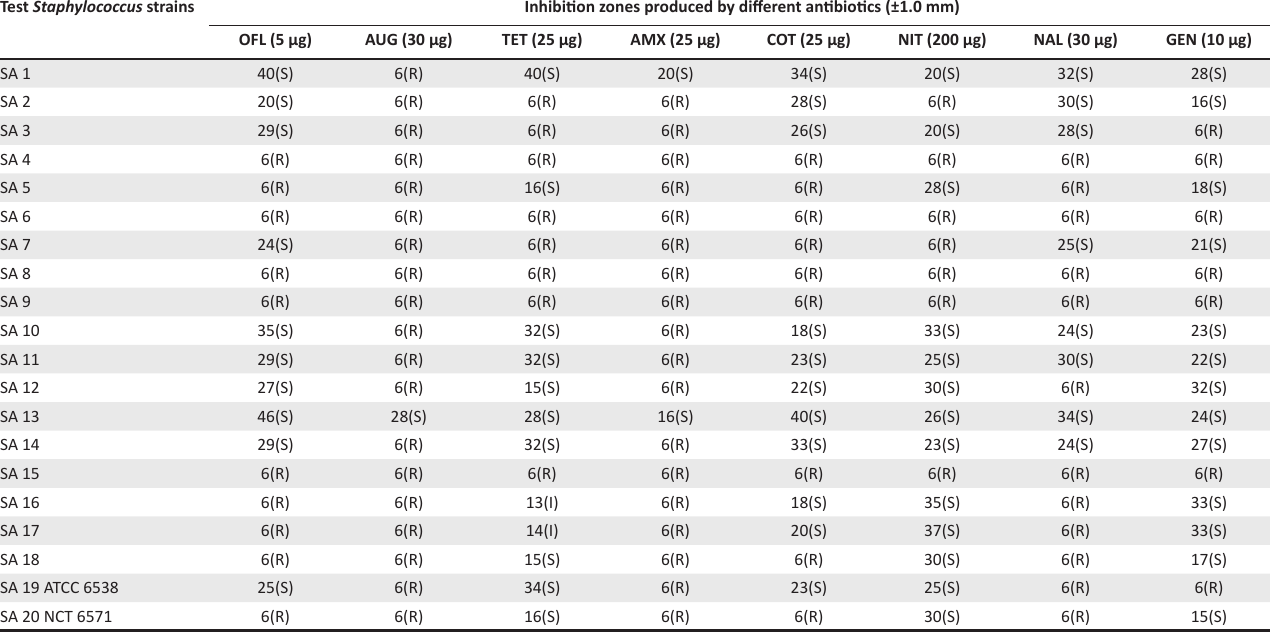
TABLE 1: Antibiotics resistance profile of different strains of Staphylococcus aureus as determined by disc diffusion assay using different antibiotic discs. Test Staphylococcus